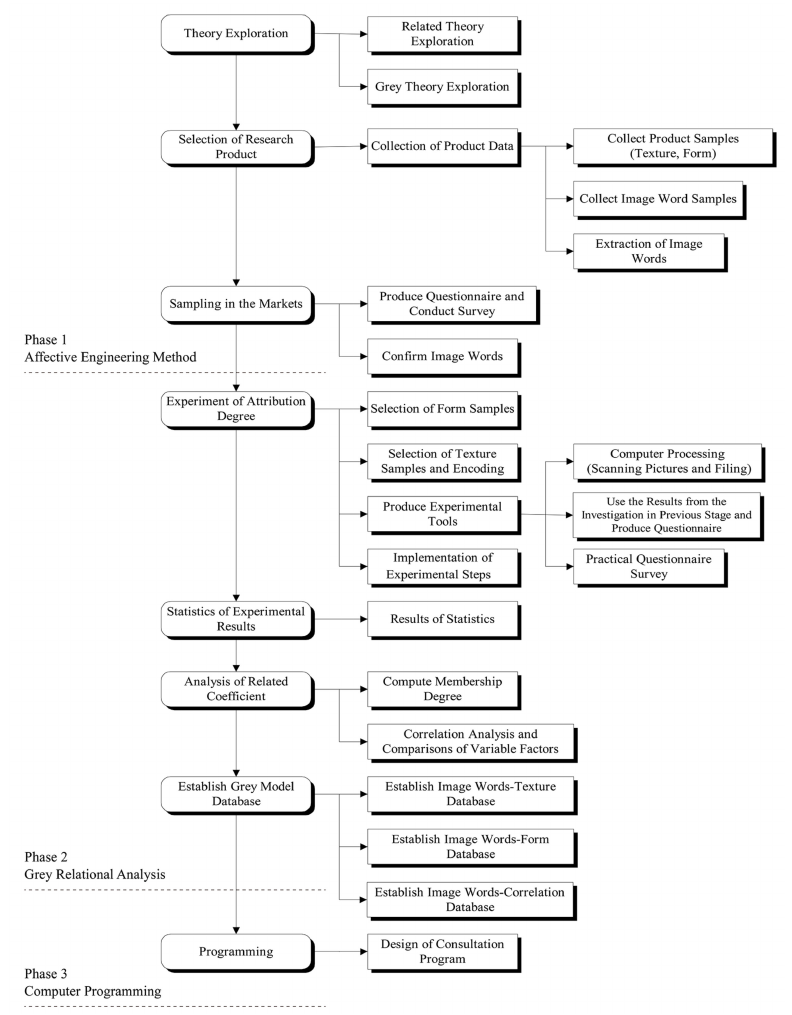
Figure 3. The flow chart of development strategy of automatic form design